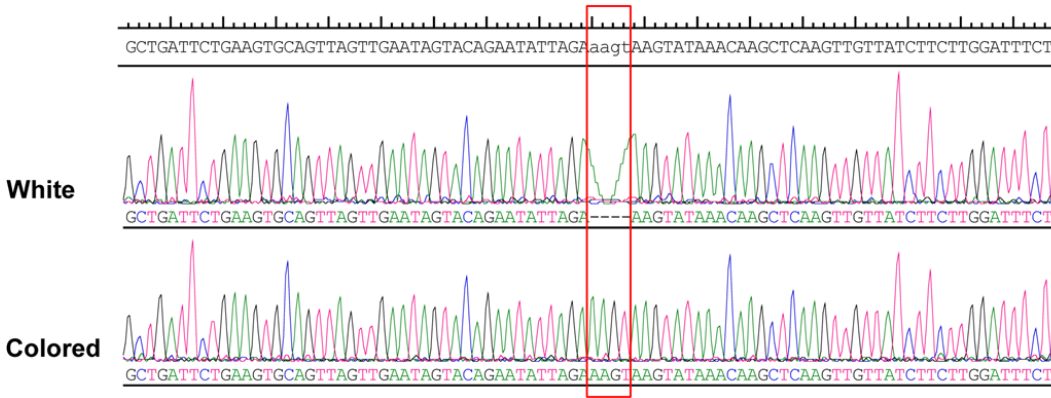
Figure 4. Sequence chromatograms of genomic regions harboring the indel. Red highlighted portion indicates insertion–deletion in the white and colored animals. Table 2. Location, frequency, and P values of significantly associated SNPs from the genome-wide association study. SNP (position) Chr. MAF P value Candidate gene (position) rs75377751 (187920668) 1 0.245283 3 . 31 × 10 − 29 TYR (187920666...187970514) rs77034318 (33305561) 7 0.309973 1 . 12 × 10 − 9 GTDC1 (33270007...33450697) rs77188285 (10474311) Z 0.474394 1 . 74 × 10 − 19 RAI14